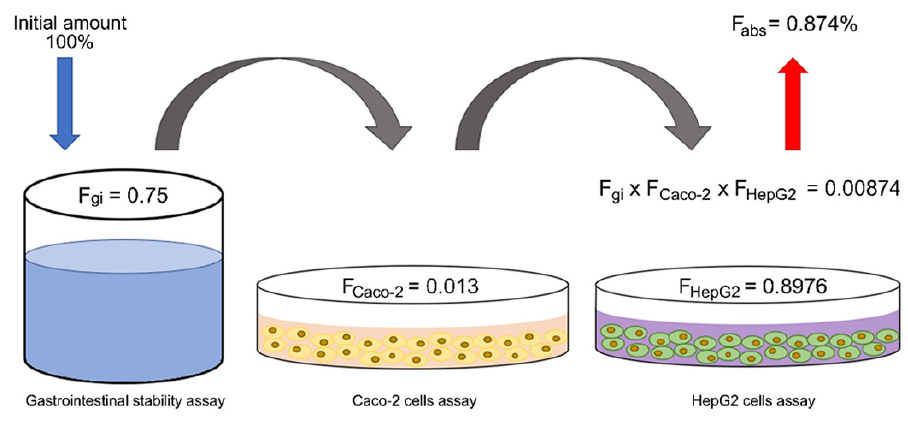
Figure 3. Scheme of processes involved in the oral absorption of rosmarinic acid (RA) and its remain- ing fraction after gastrointestinal stability (F gi ), intestinal absorption (F Caco-2 ), hepatic